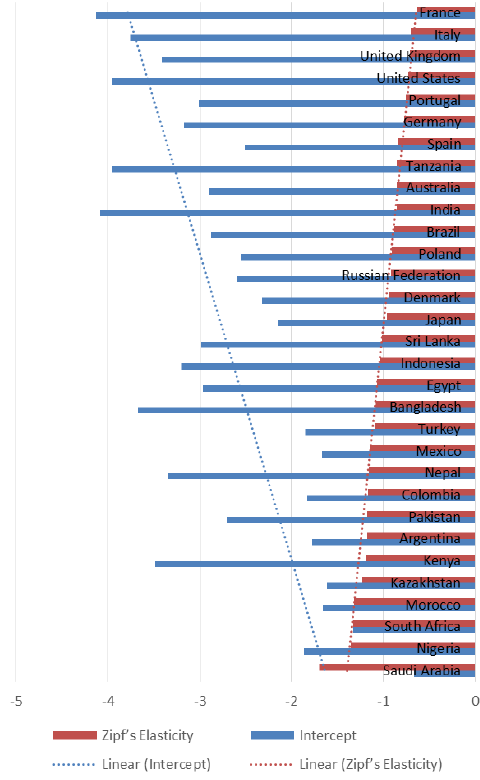
Figure 3: Zipf ’s elasticity and intercept by